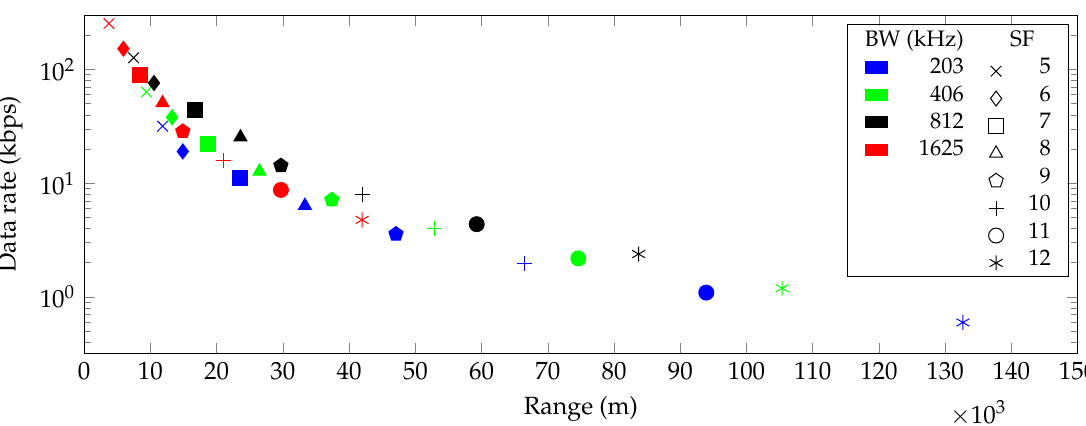
Figure 2. Communication range and data rate for every combination of spreading factor (SF) and bandwidth (BW) in a free space line of sight (LoS) environment.